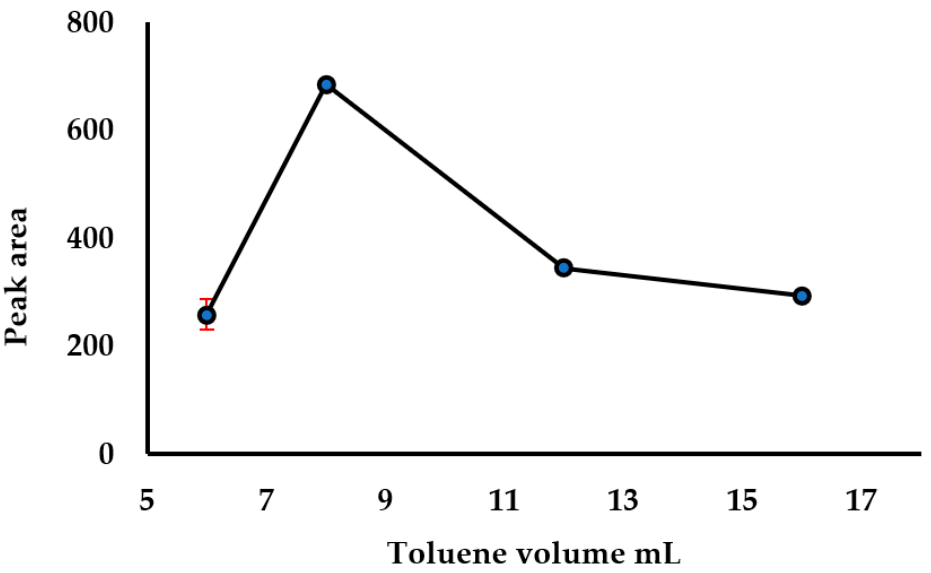
Figure 3. Effect of toluene volume in extraction efficiency.